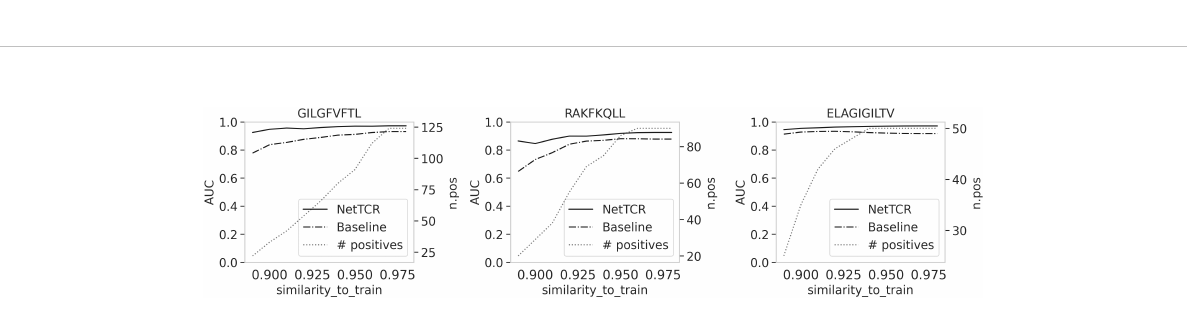
FIGURE 9 AUC values as a function of the similarity between training and evaluation set. Percentile rank transformation was applied to the TCRs and only positive TCRs with a rank score less than 0.3 were kept in this analysis. For each TCR in the evaluation set, we calculated the similarity to the training set using the kernel similarity score. We then removed the TCRs with a similarity above a threshold and calculated the AUC. The curves in the plots show the AUC varies when different similarity thresholds were used to fi lter the evaluation set; 10 similarity values between 0.89 and 0.98 were chosen. The dashed line shows the number of positive TCRs left in the evaluation set at each step of fi ltering by similarity to the training